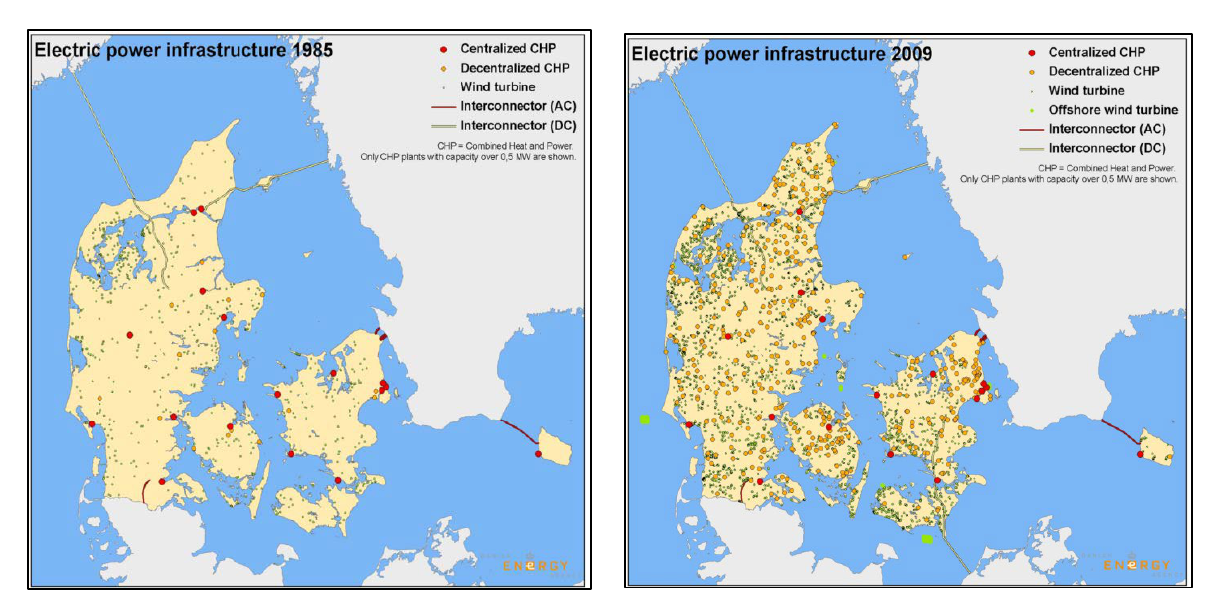
Figure 8. Centralized and decentralized CHPs in Denmark. Left: year 1985. Right: year 2009. Source: [69].